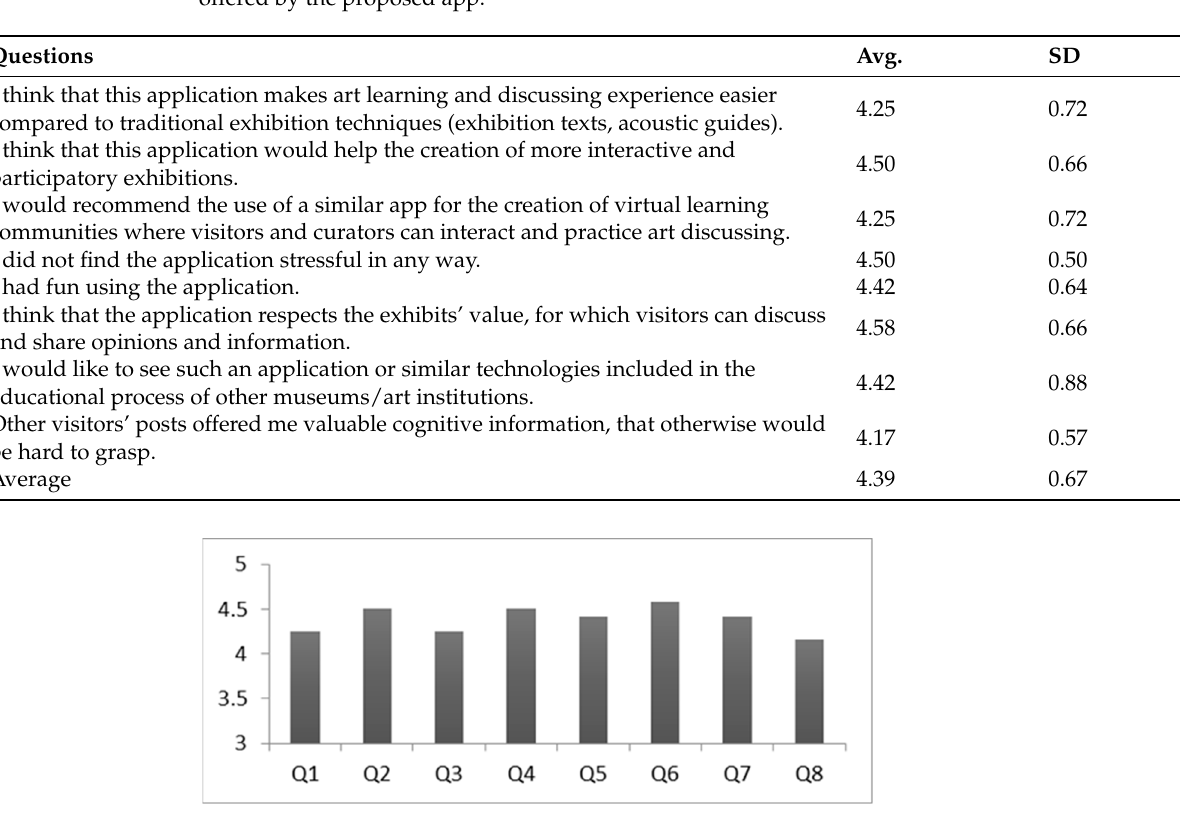
Table 7. Questions and average ratings of participants’ attitude concerning the learning experience offered by the proposed app.